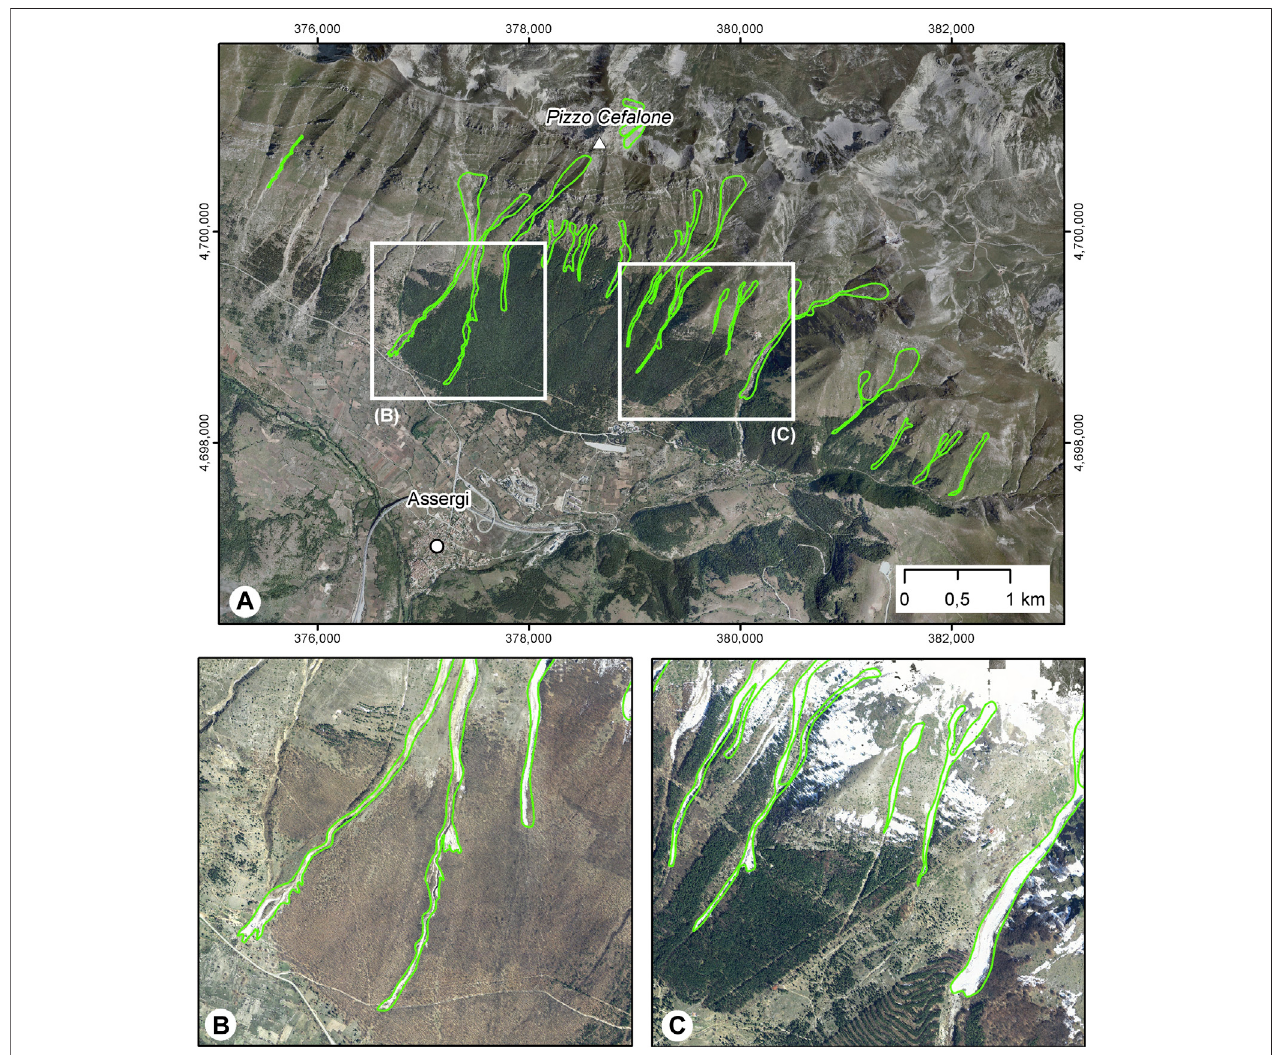
FIGURE 5 | Evidence of snow avalanches (green lines) on April 2009. (A) Entire Assergi-Pizzo Cefalone area (on orthophotos taken April 8, 2009). (B) Detail of the evidence on SW slope of Pizzo Cefalone (west part, see A for location). (C) Detail of the evidence on SW slope of Pizzo Cefalone (east part, see A for location).